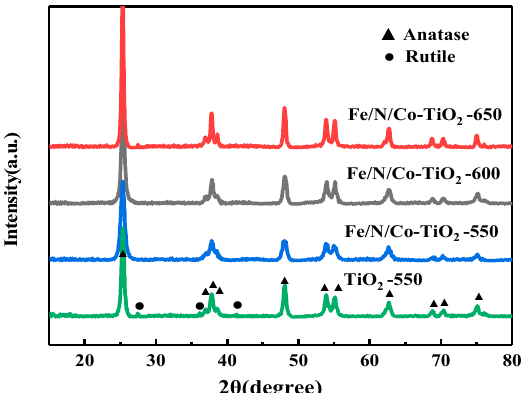
Figure 4. The XRD patterns of doped-TiO 2 after calcination at different temperatures.